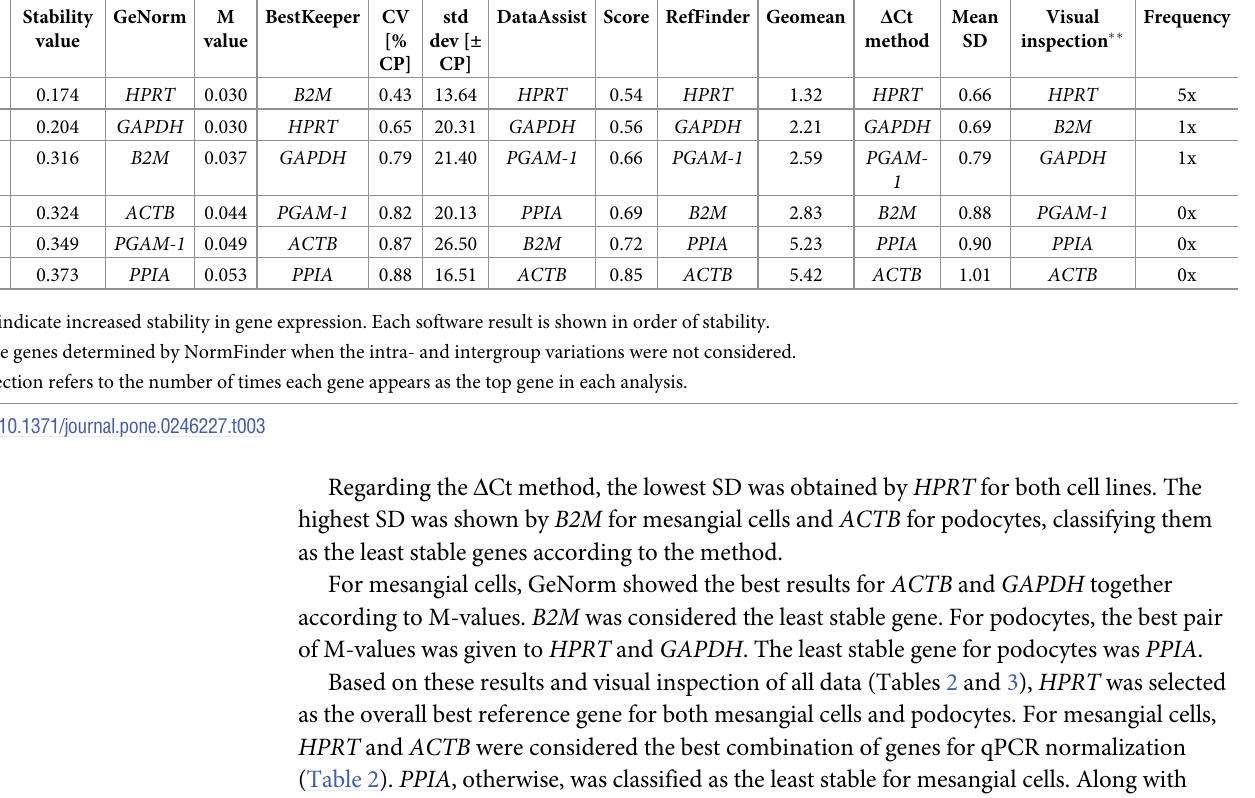
Table 3. Ranking of candidate reference genes by each method used for podocytes. NormFinder � Stability